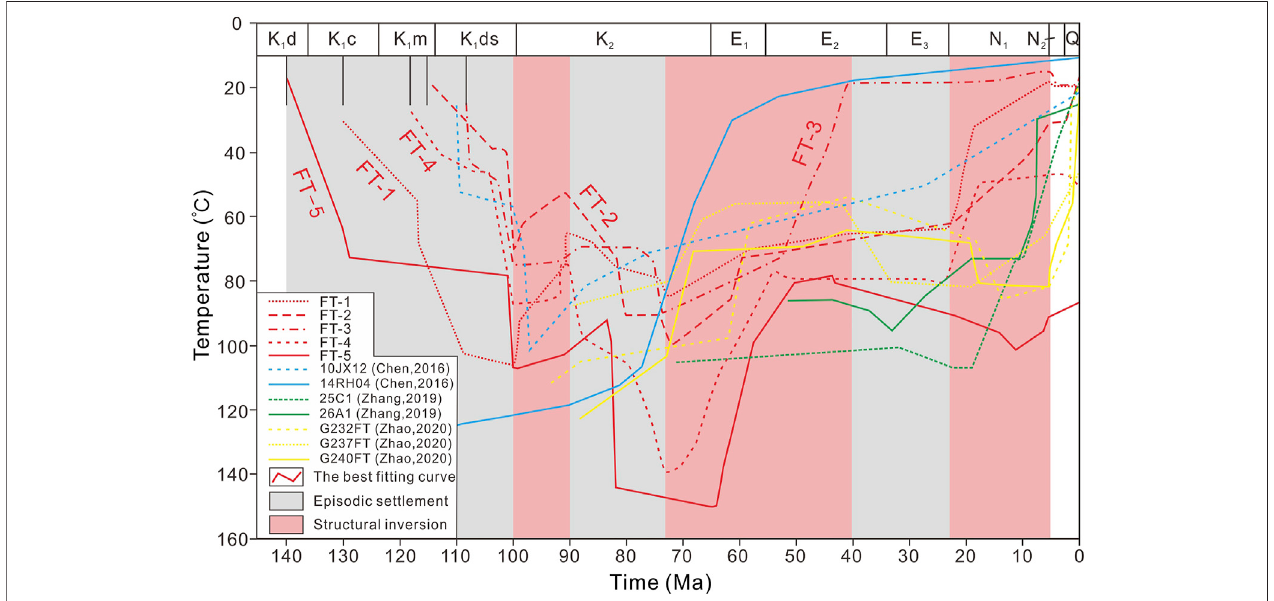
FIGURE 7 | Comprehensive analysis of tectonic-thermal evolution process of the Dasanjiang area. The lines of different colors and styles indicate the best thermal history path of the sample and the thermal history simulation results of predecessors (modi fi ed after Chen, 2016; Zhang, 2019; Zhao, 2020).